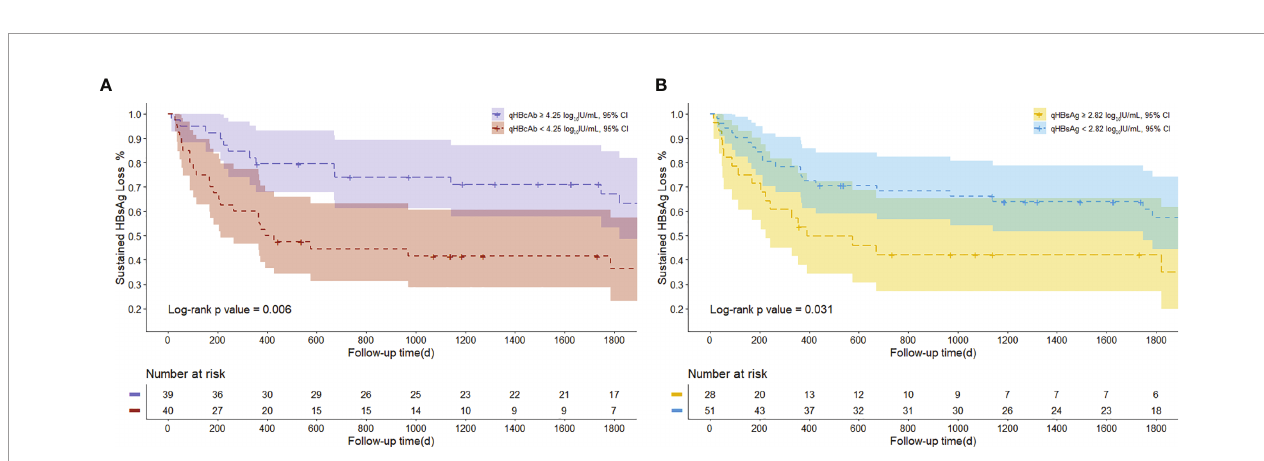
FIGURE 4 | The Kaplan-Meier curve of HBsAg conversion rates at the last time of follow-up. (A) The proportion of patients with sustained HBsAg loss according to qHBcAb at baseline. (B) The proportion of patients with sustained HBsAg loss according to qHBsAg at